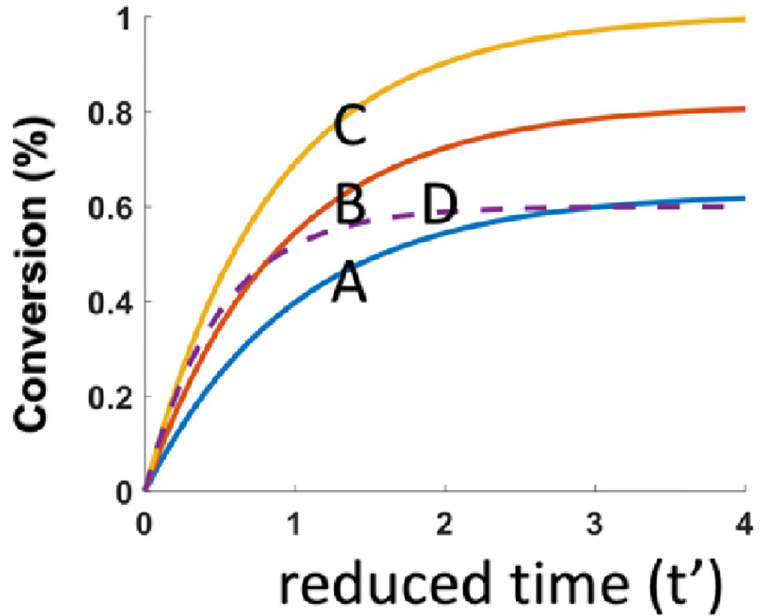
Fig 1. Efficacy of FRP and CP for various N 0 = (0, 0.5, 1.0), for Curve-A, B, C (for FRP); and Curve-D (for CP0; for fixed b = 1.0 and B 0 =